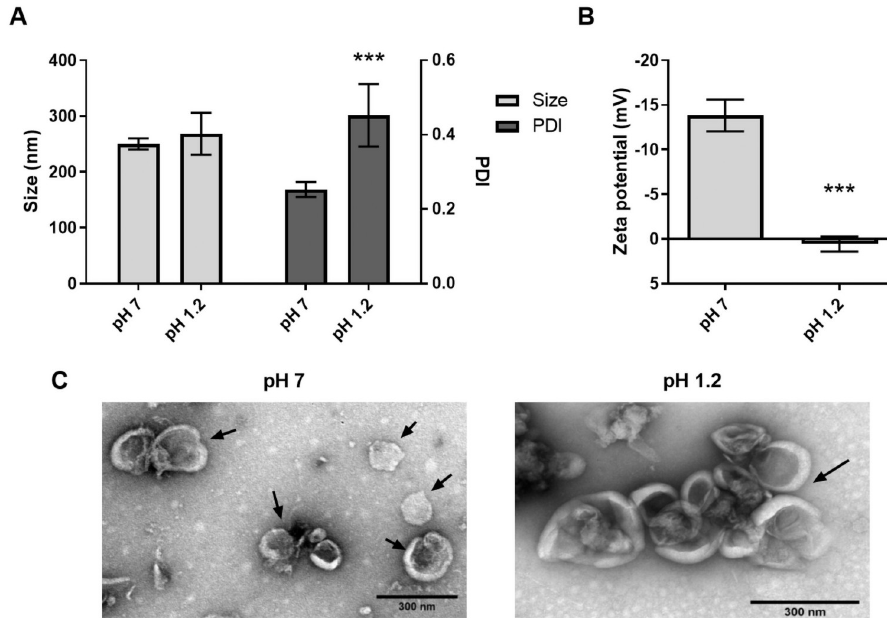
Fig 5. The tolerance of the KPEVs under a simulated gastric condition. The size distribution (A, left), PDI (A, right), and zeta potential (B) of the KPEVs before and after incubation under the simulated gastric condition. (C) KPEV morphology in neutral pH 7.0 and acid pH 1.2 were visualized by TEM; the scale bar indicates 300 nm. The experiments were performed in at least triplicates, and the data are presented as the mean ± SD. The statistical analysis was performed using one-way ANOVA followed by the Bonferroni test. ( ��� ) indicates a P-value of p � 0.001 compared to KPEVs at pH 7.0.